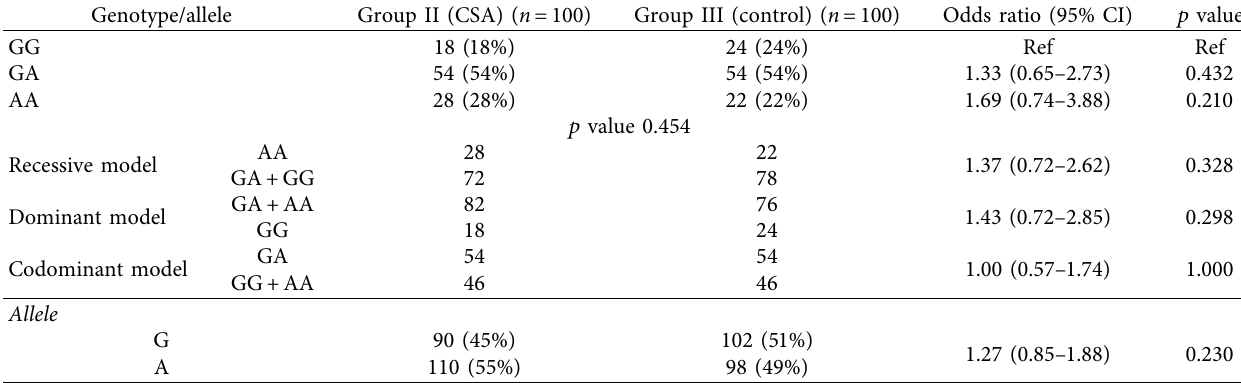
Table 7: Distribution of genotype and allelic frequency and association analysis of -844G/A polymorphism with CSA under different genetic models.